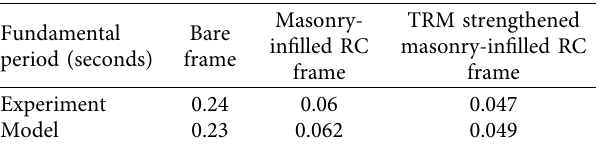
Figure 6: (a) Comparison of the results between the numerical model using the total strain crack model with the fiber-reinforced concrete model (fib) and the experimental test and (b) numerical results for the cyclic behavior of two layers of glass TRM in terms of stress-strain. Table 4: Comparison of experimental and numerical fundamental